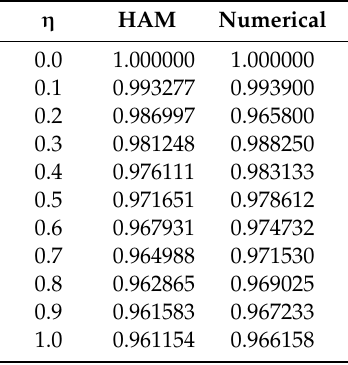
Table 4. The assessment of the HAM and ND-Solve for θ ( η )